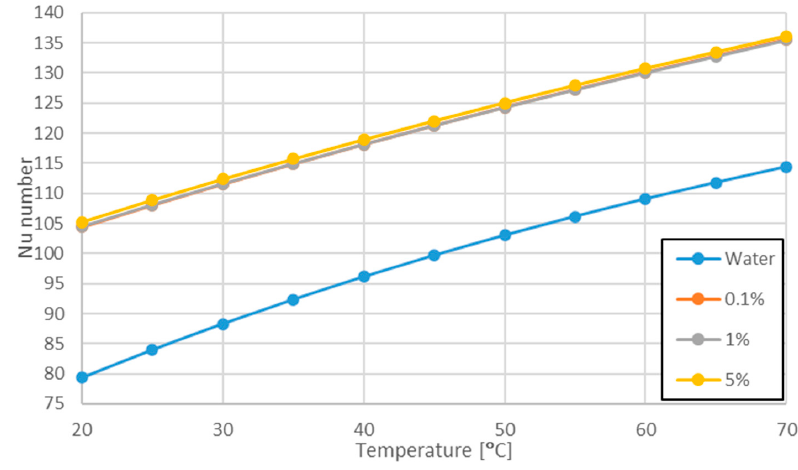
Figure 17. Variation of Nu number for water-Al 2 O 3 nanofluids.